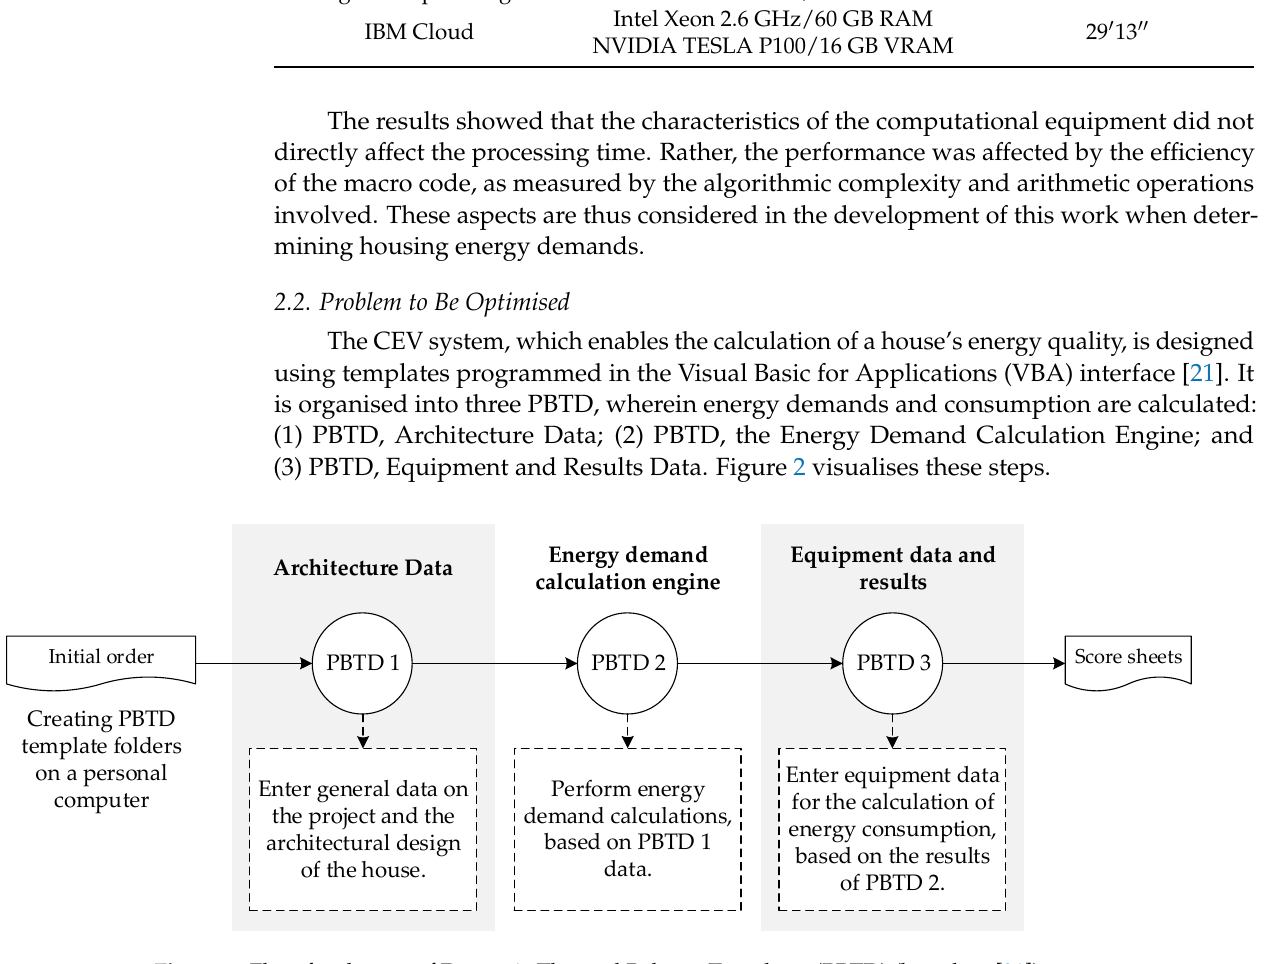
Figure 2. Flow for the use of Dynamic Thermal Balance Templates (PBTD) (based on [21]).